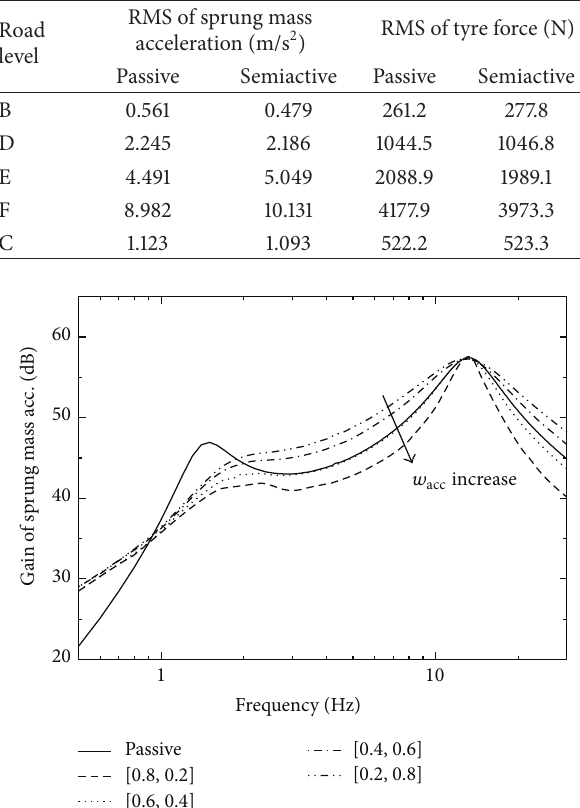
Table 4: Comparison of ride comfort and road handling.